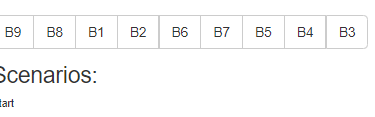
Figure 3. One possible order of insertion of the activity of the observed process.